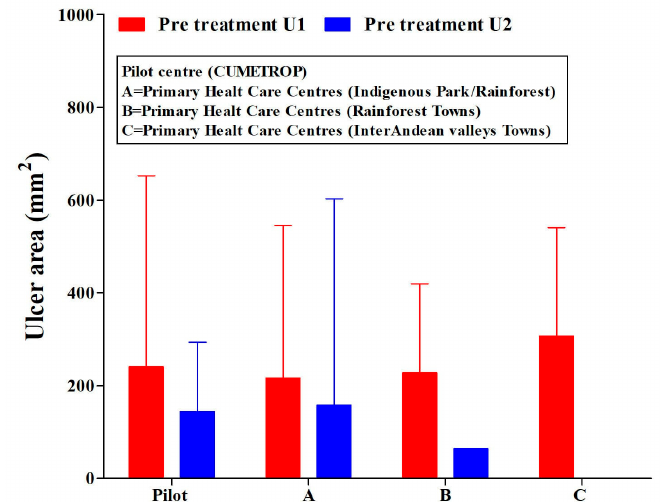
Figure 2. Ulcer areas (single or two ulcers) in cutaneous leishmaniasis patients. Pre-treatment with the intralesional application of meglumine antimoniate, regarding the settlement of primary health care centres and pilot centre. U1 = ulcer-1; U2 = ulcer-2. CUMETROP = Centro Universitario de Medicina Tropical. The data are presented as Mean (SD) ANOVA test (U1, p = 0.833; U2, p = 0.951).